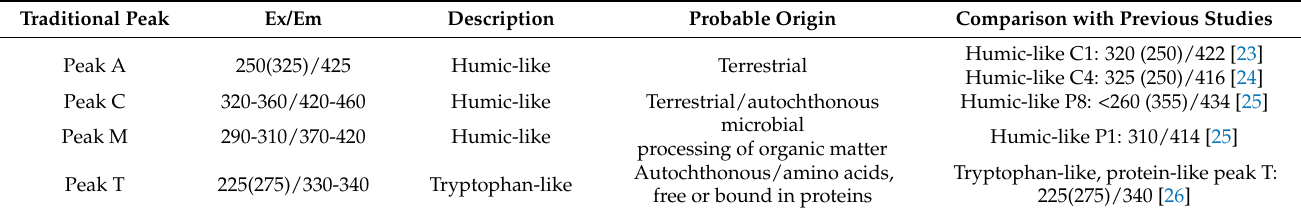
Table 3. Central regions of EEM fluorescence attributed to different sources of organic matter compared with previous studies.